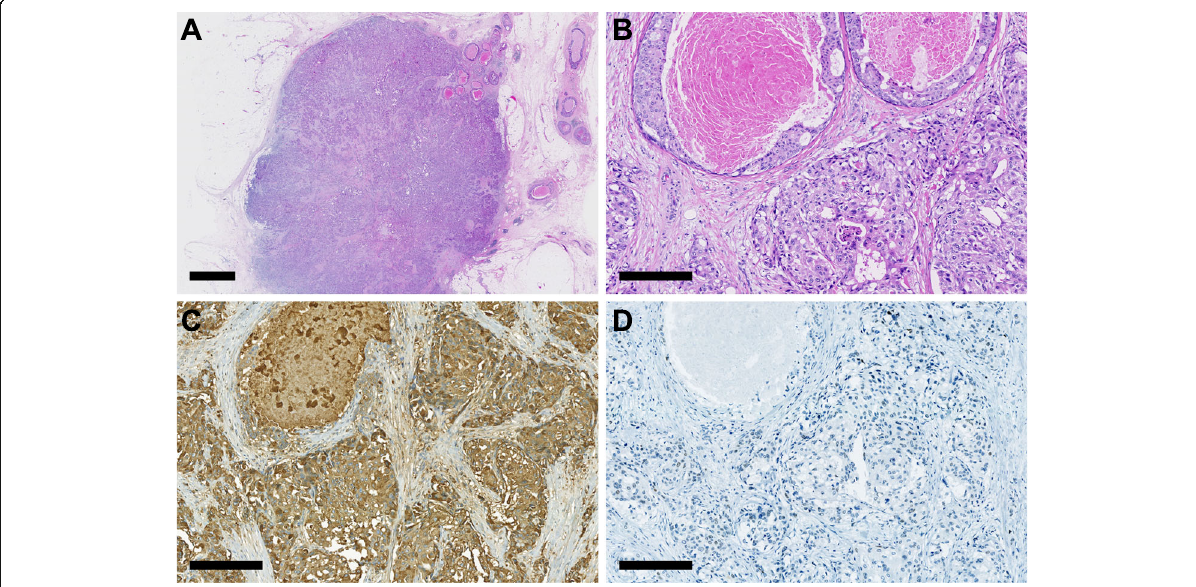
Fig. 4 Image of a previous breast cancer. a Representative whole-slide and b magnified hematoxylin and eosin staining images of the tumor. c Representative images of GCDFP-15 and d p53 immunostaining. Black bars: 2.5 mm ( a ), 250 μ m ( b - d